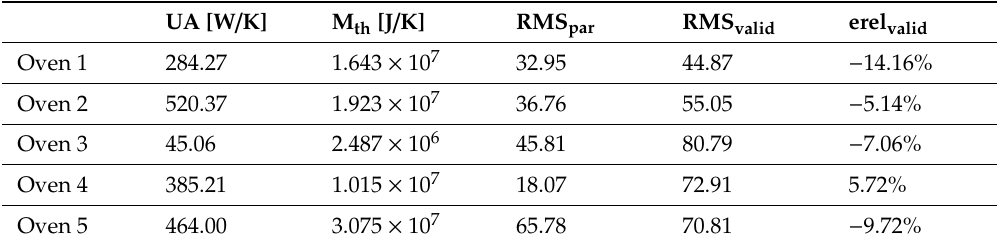
Table 1. RMS and relative error for parametrization and